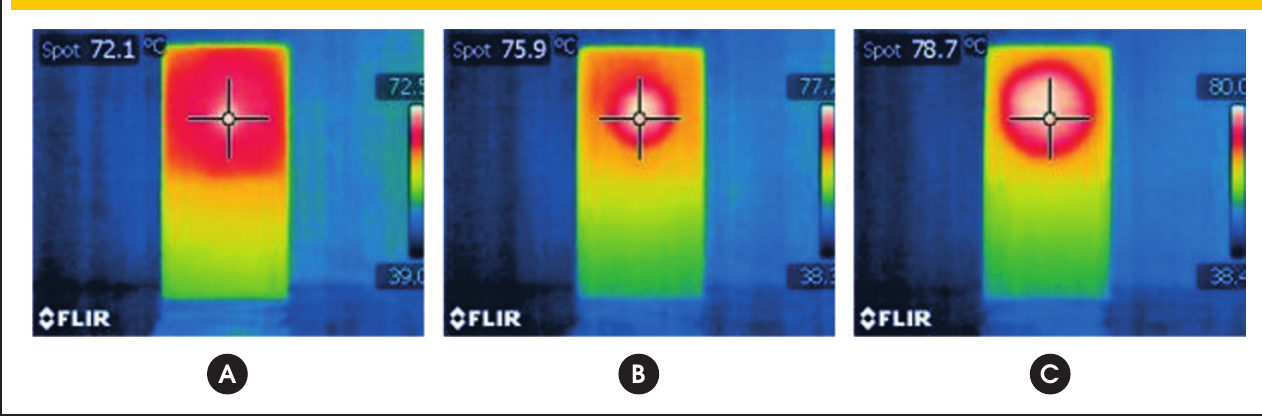
Figure 36 – Infrared images indicating the temperature in the point of the artificial defect th when thermal emissivity inserted was 0.1 (4 measurement): (a) CP2, (b) CP3, (c)